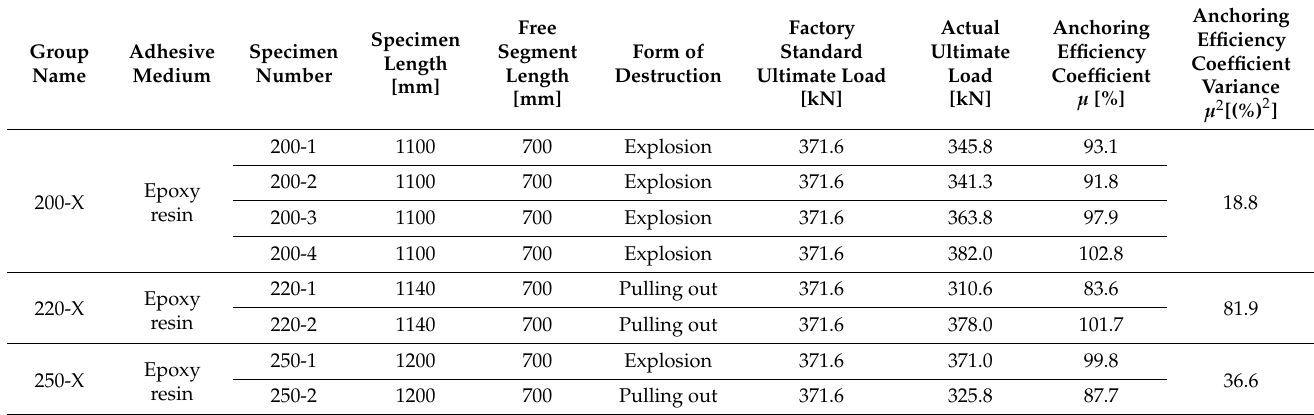
Table 4. Statistical results and the failure modes of anchor control specimens.